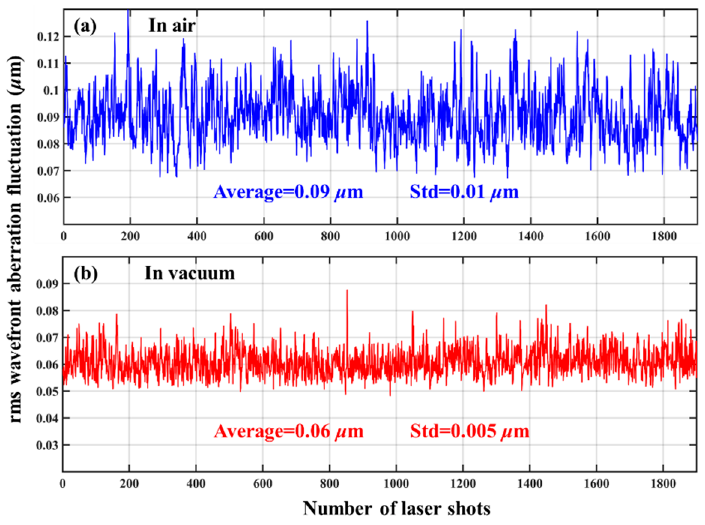
Figure 6. The fluctuation of RMS wavefront aberration of 1900 shots successive laser pulse operating at 1 Hz ( a ) in air and ( b ) in vacuum.